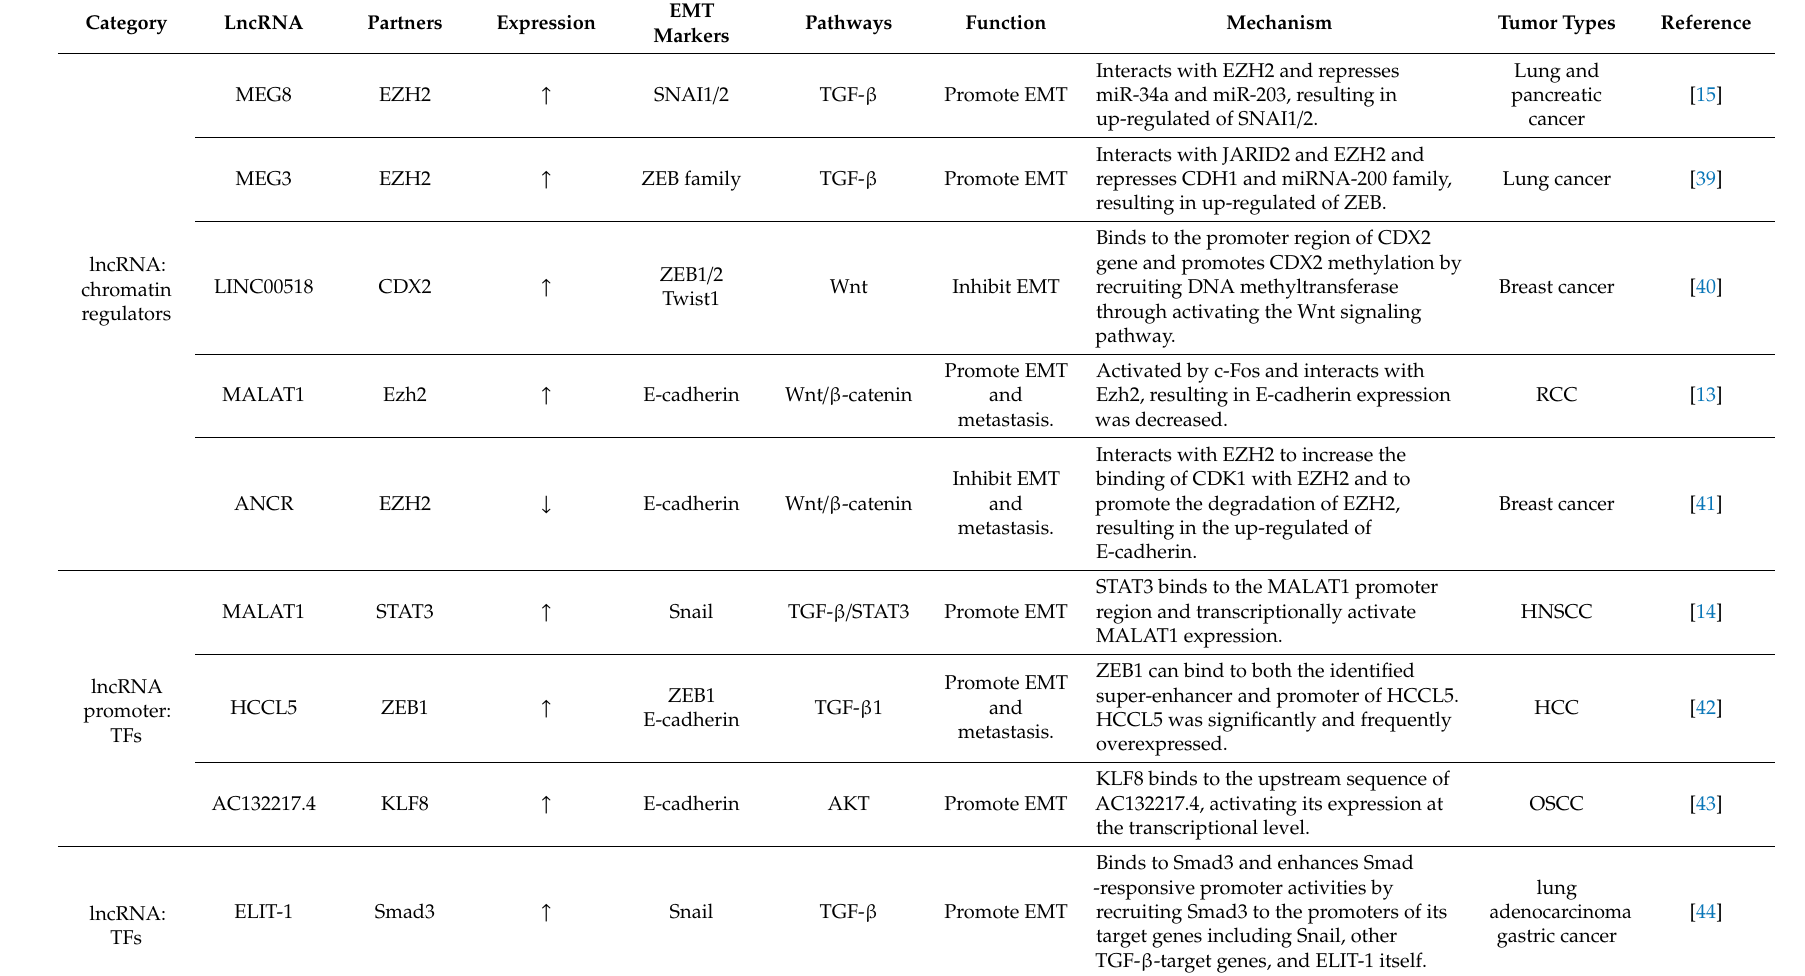
Table 1. Examples of lncRNAs that interact with various molecules in Epithelial-mesenchymal transition